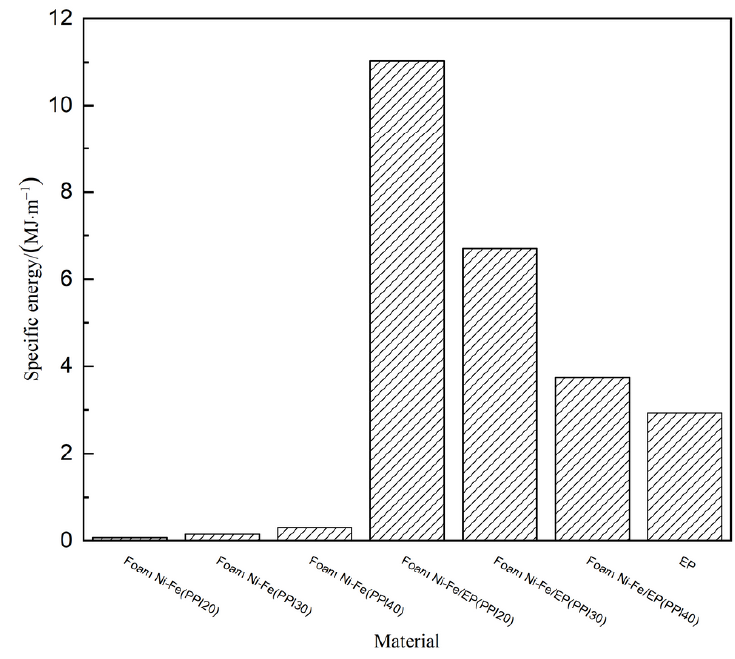
Figure 8. Unit volume energy absorbing of the seven materials.